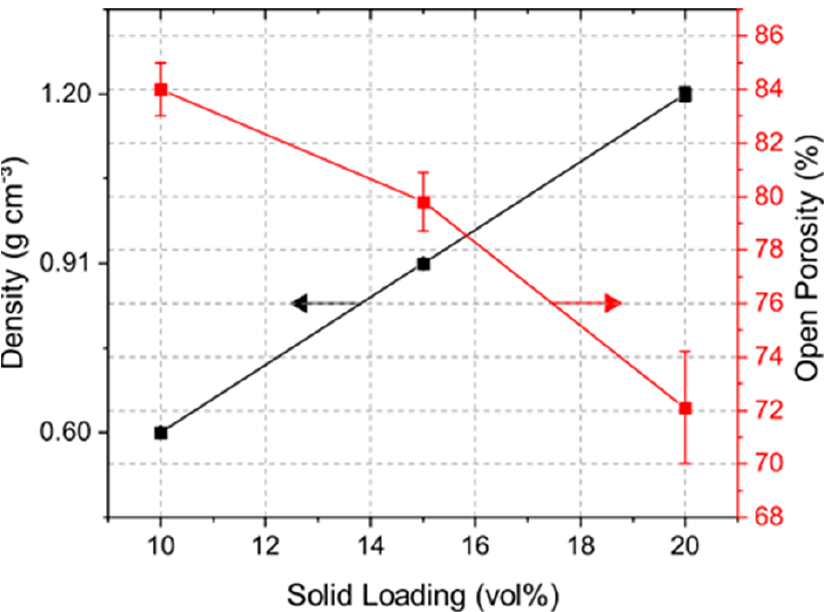
Figure 3. Density and open porosity determination via Archimedes’ principle.